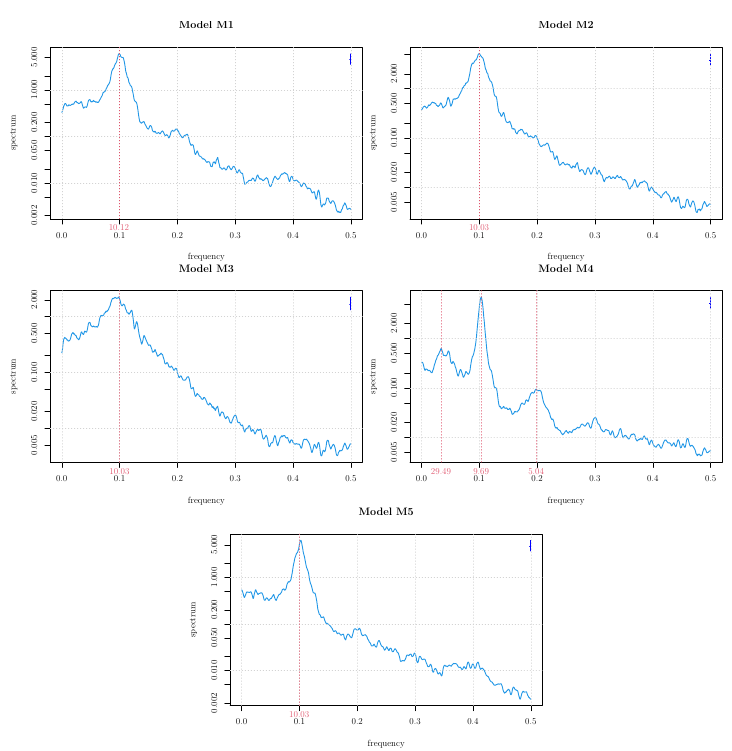
Figure 6 – Spectral density of time series of length 10000 simulated from TAR models. The dashed line indicate the prominent pikes and the corresponding periods are